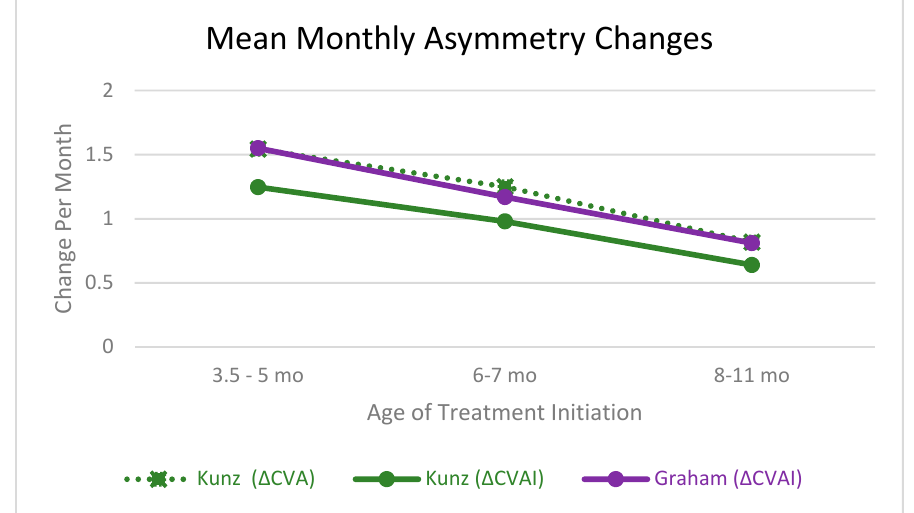
Figure 3. Study comparison of mean monthly asymmetry changes based on infant starting age (Kunz n = 144, Graham n = 473).